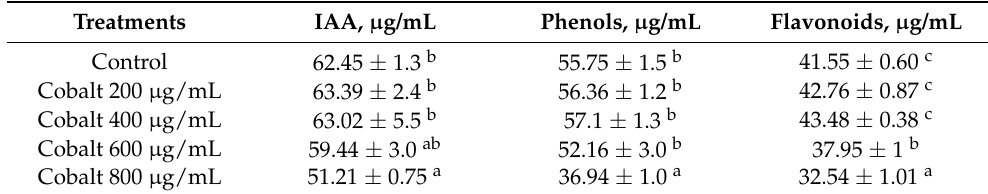
Table 2. Effect of different concentrations of cobalt stress on the secretion of IAA, phenols and flavonoids. Treatments